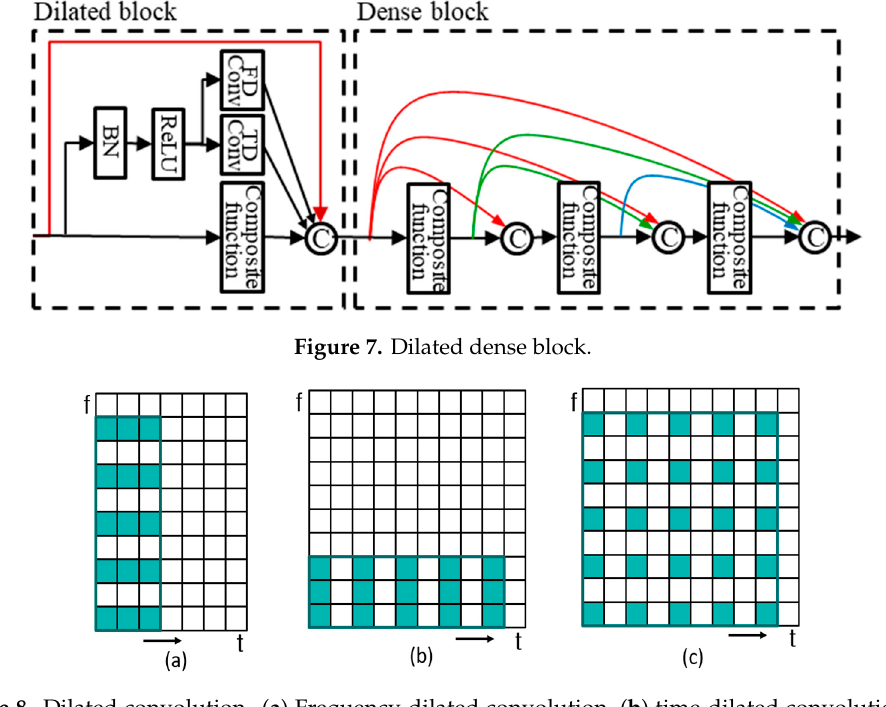
Figure 8. Dilated convolution. ( a ) Frequency-dilated convolution, ( b ) time-dilated convolution, ( c ) 2-dilated convolution.